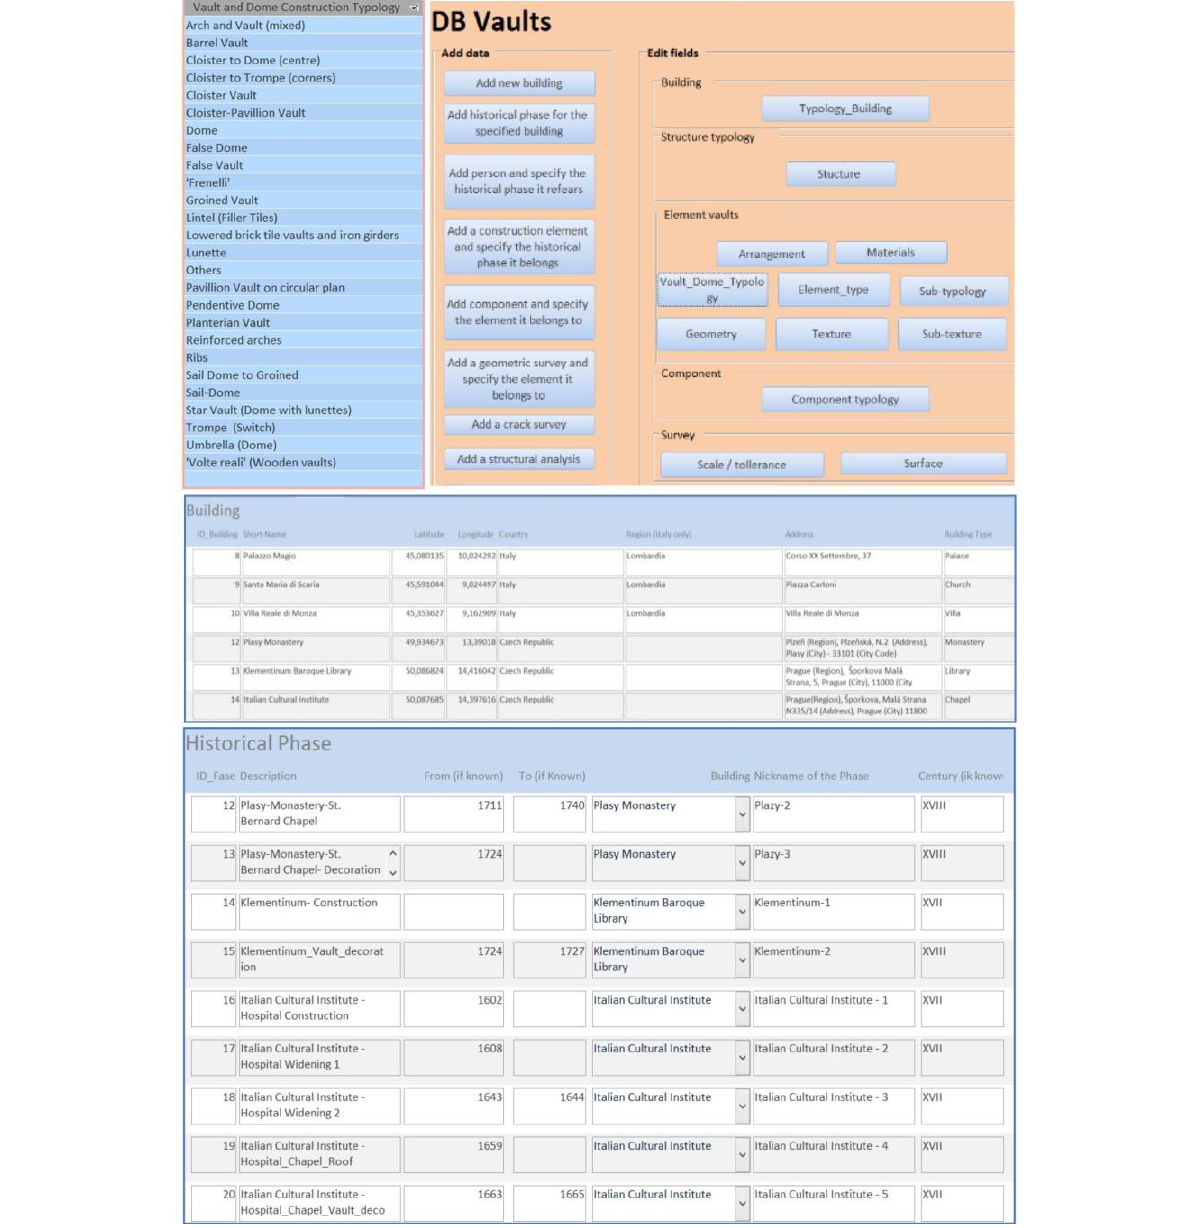
Figure 3. The Vault Data Base with the different description tables related to the Buildings, the Typologies and the Historical Phases of the vaulted systems. The DB has been populated by the HBIM information